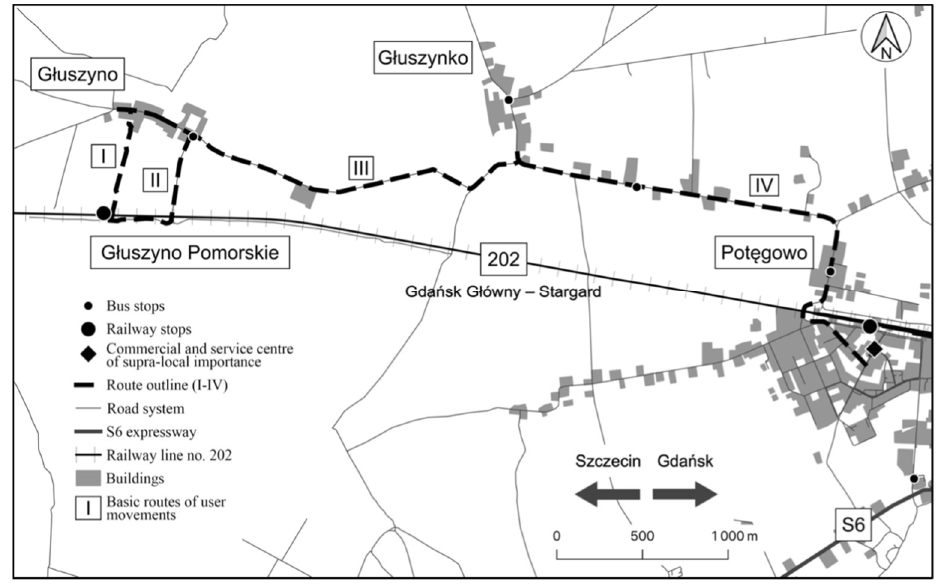
Figure 11. Road and rail accessibility to G ł uszyno (own study, based on [45,92]).